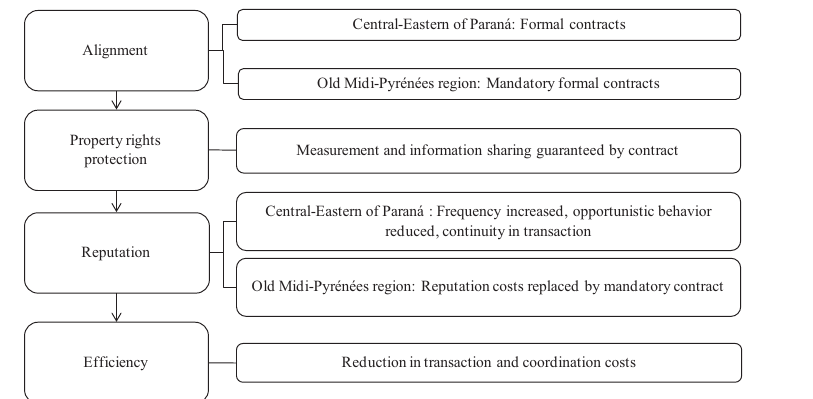
Figure 2. Results in cases